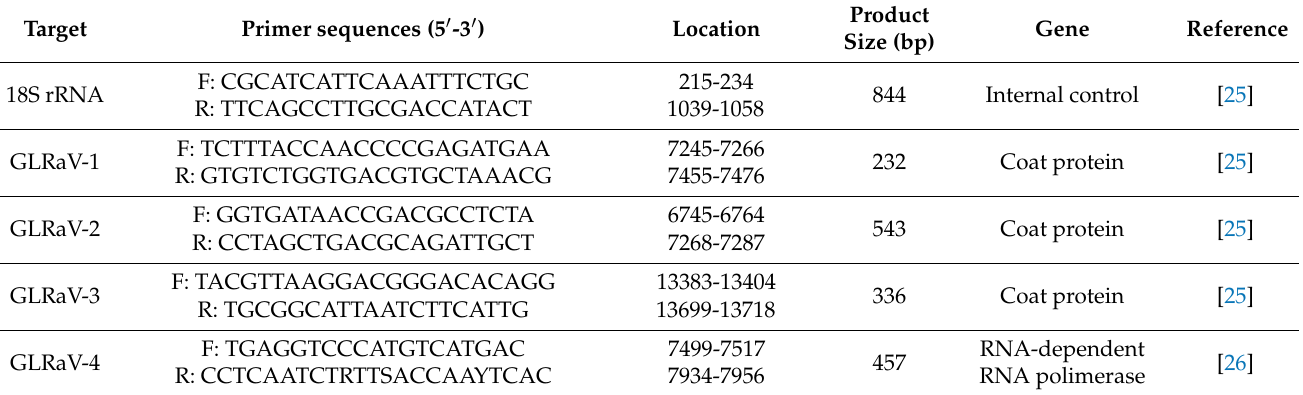
Table 2. Primer sequences used in the RNA analysis for screening of eight grapevine viruses.